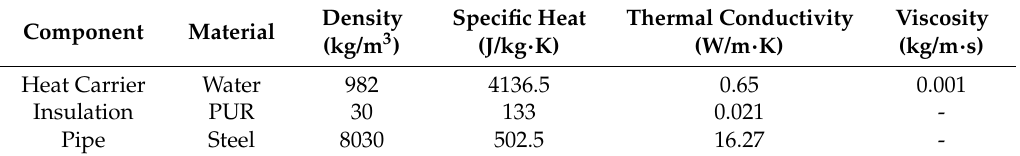
Table 2. Further information about the characteristics of the pipes and district heating medium (i.e., water). Table 2. Characteristics of twin-pipes and district heating flow through the pipes [26].